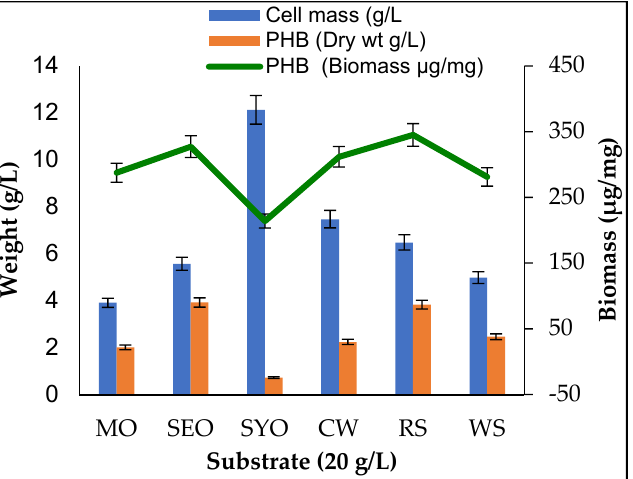
Figure 5. PHB accumulation in Pseudomonas sp. RZS 1 during 30 h growth at 30 °C and 120 rpm in NDM separately amended with crude vegetable oil and agro-wastes (20 g/L) as carbon substrates.